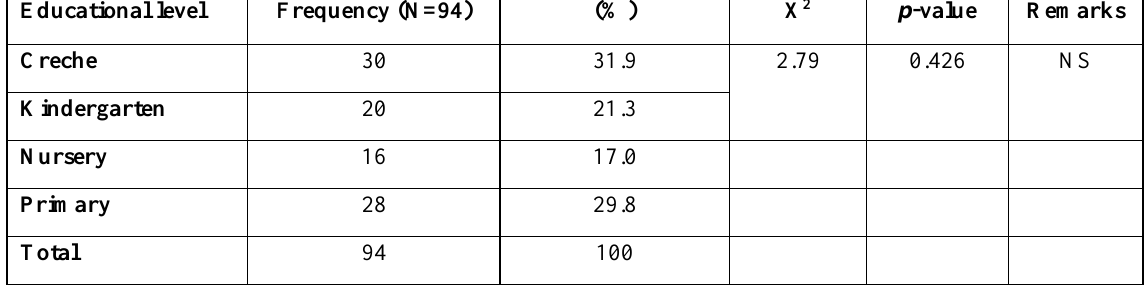
Table 5. Distribution of astrovirus among children in Offa based on educational level.